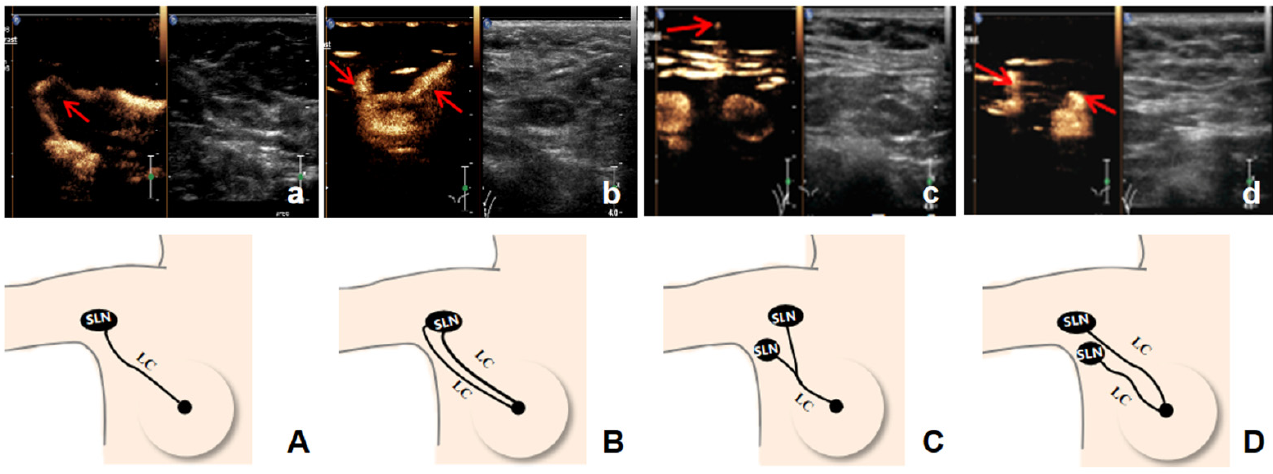
Figure 4. Schema of the four types of lymphatic drainage patterns (LC = lymphatic channel, SLN = sentinel lymph node; the arrows represent LC): ( a , A ) Single LC to single SLN; ( b , B ) Multiple LCs to single SLN; ( c , C ) Single LC to multiple SLNs; ( d , D ) Multiple LCs to multiple SLNs.